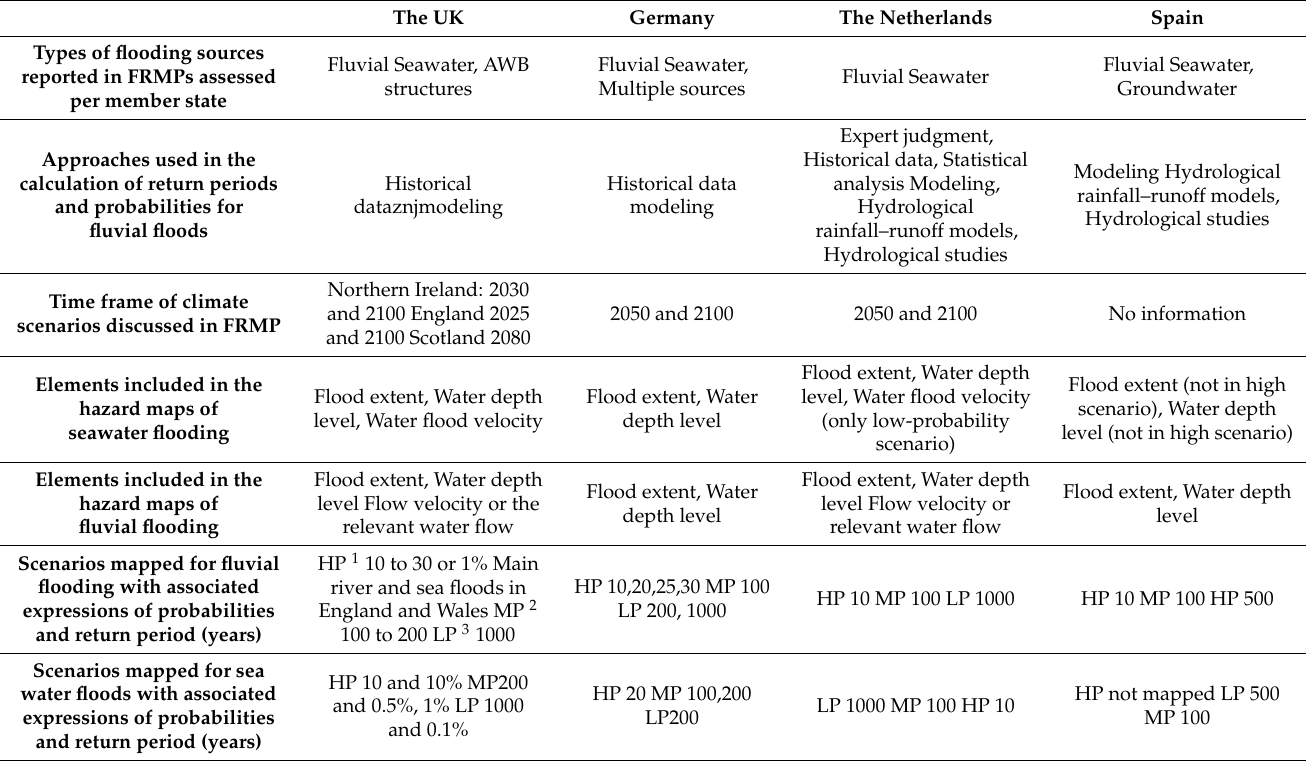
Table 1. Methodologies in the first cycle of implementation of the FD. Own elaboration based on documents: “EU overview of methodologies used in the preparation of Flood Hazard and Flood Risk Maps” [55] and “European Overview-Flood Risk Management Plans”